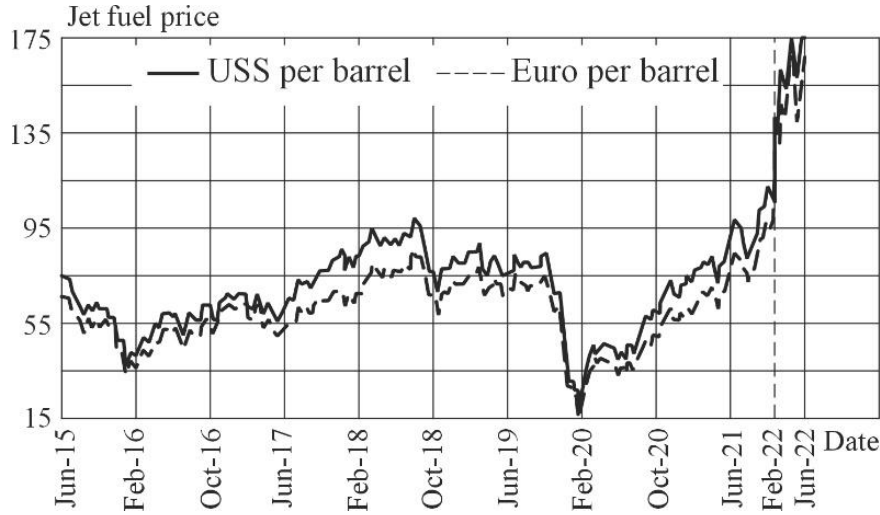
Figure 1. Dynamics of aviation fuel cost change (Source: S&P Global, Refinitiv Eikon).